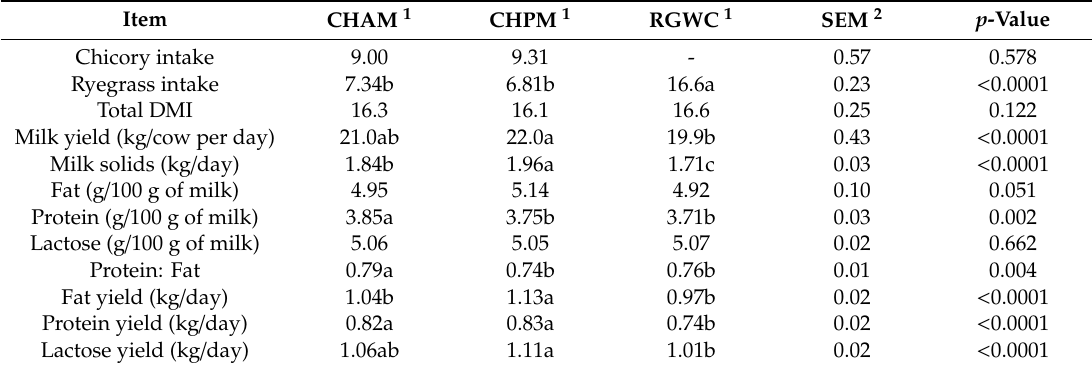
Table 2. Estimated dry matter intake (DMI; kg / cow per day of DM), milk yield and milk composition from cows fed grazing CHAM, CHPM, and RGWC.